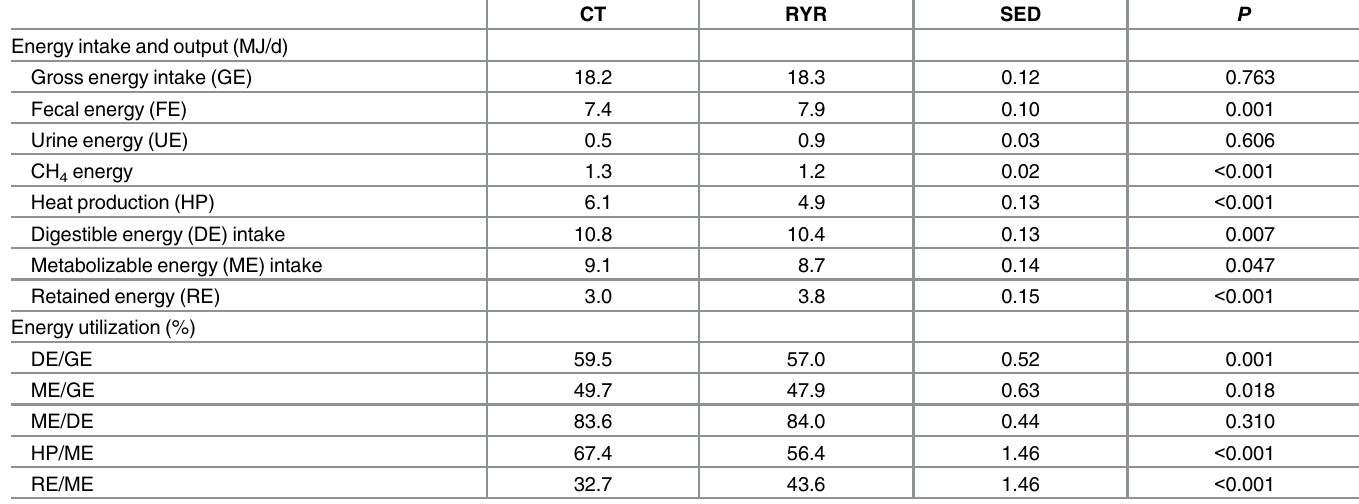
Table 4. The effect of replacement of ordinary rice with red yeast rice on energy metabolism in goats (n = 20).